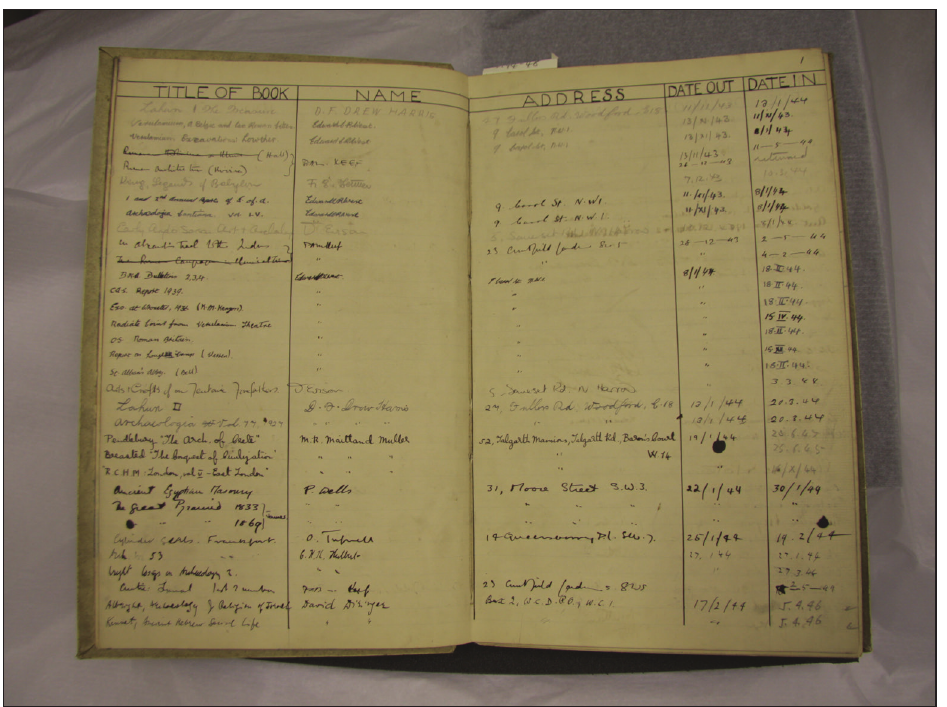
Figure 1: Institute of Archaeology Borrowing Ledger 1944–1947 (Photo UCL Institute of